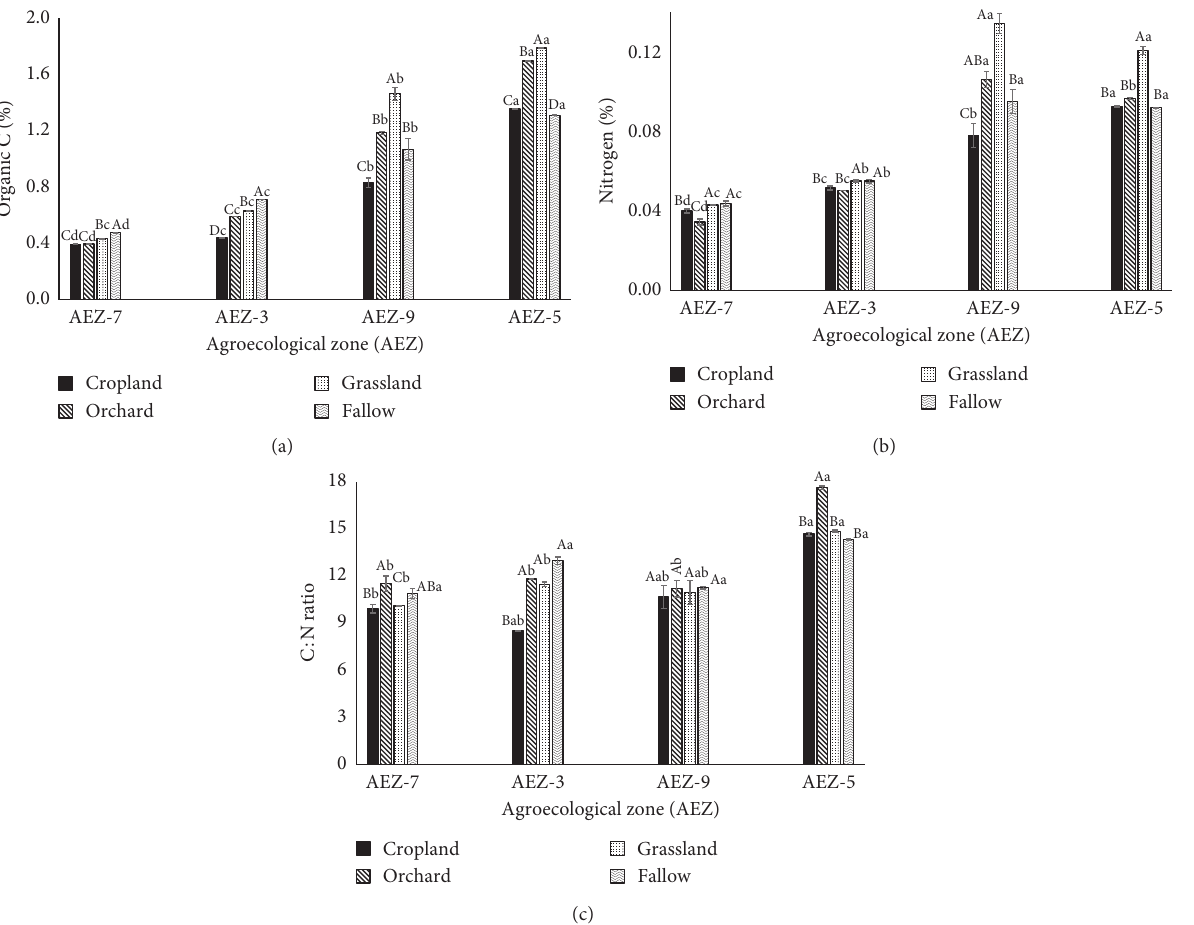
Figure 2: Amount of total organic carbon (a), nitrogen (b), and C: N ratio (c) in bulk soils of four agroecological zones (AEZs) under different land uses. Vertical bars represent standard error. Uppercase letters indicate significant differences ( p < 0 . 01) among land uses of the corresponding AEZ, and lowercase letters indicate significant differences between AEZs at corresponding land use.